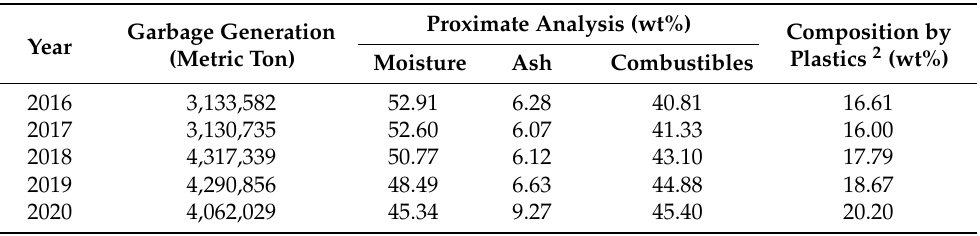
Table 4. Reported amounts of garbage (general waste) generation, proximate analysis and composi- tion by plastics in Taiwan since 2018 1